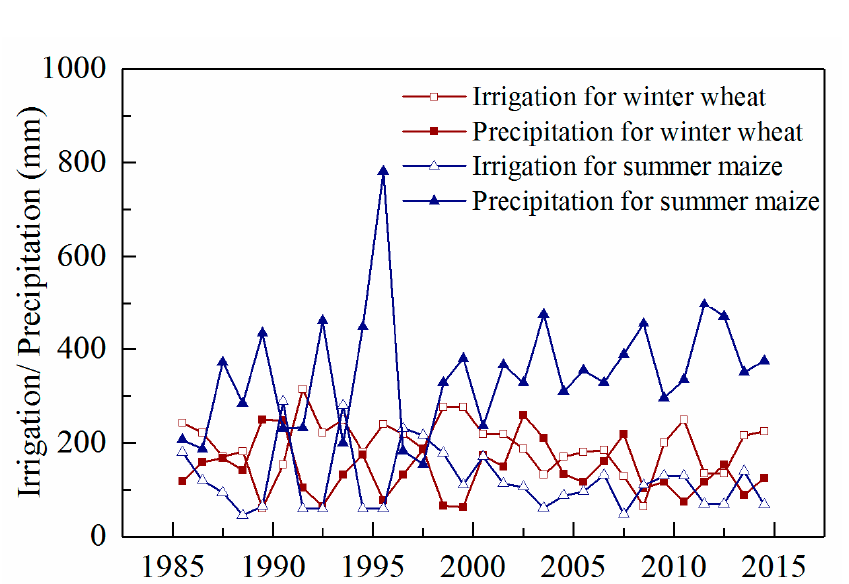
Figure 1. The amount of irrigation and precipitation in the growth period of winter wheat and summer maize at the Luancheng Agro-Experimental Station (LAES) in the North China Plain over the past 30 years (1986–2015).